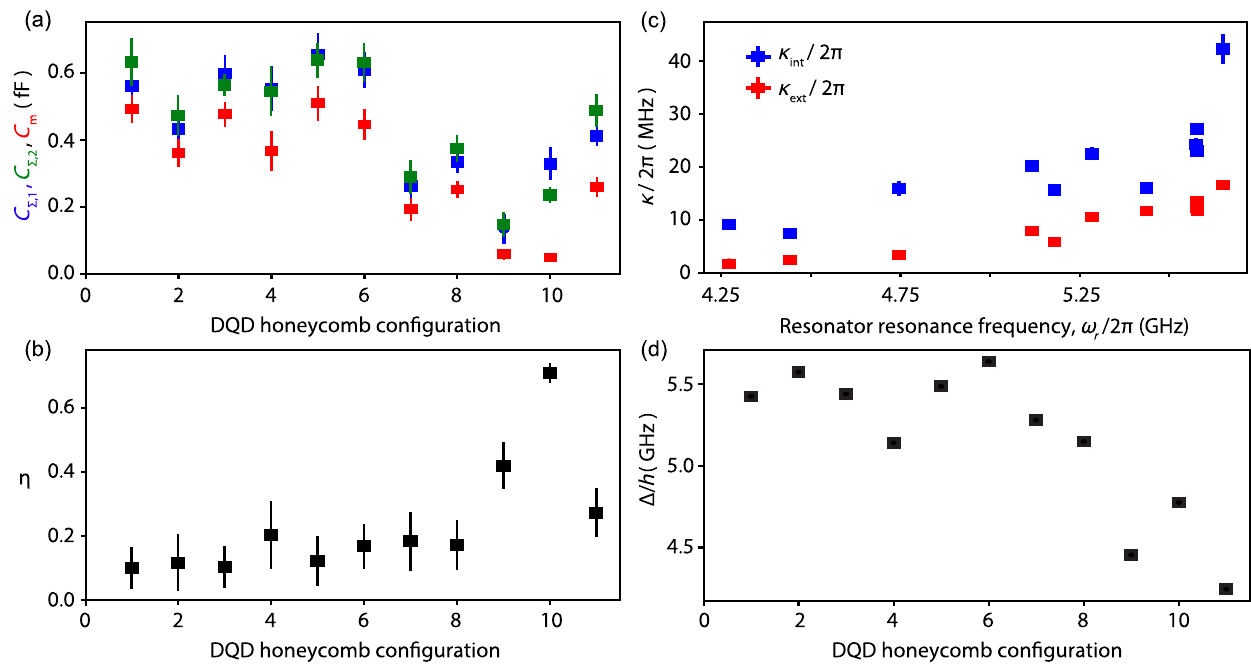
, C Σ , and C . ; 1 ; 2 m